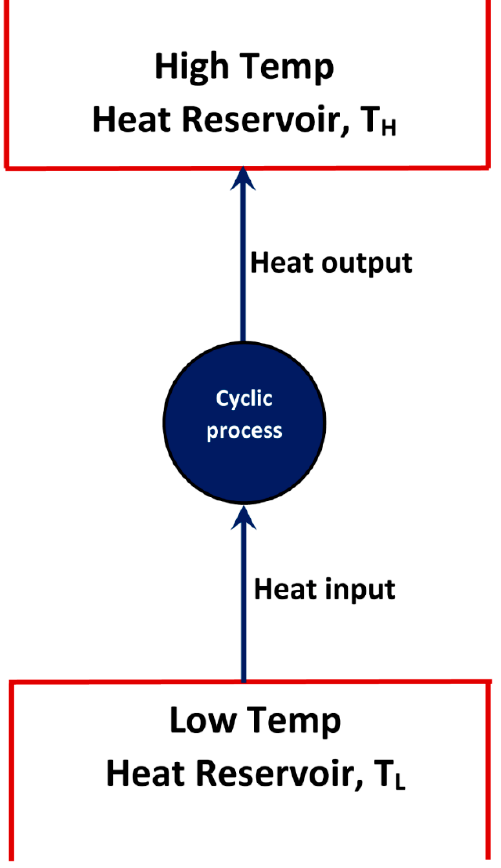
Figure 2. Impossible scheme.